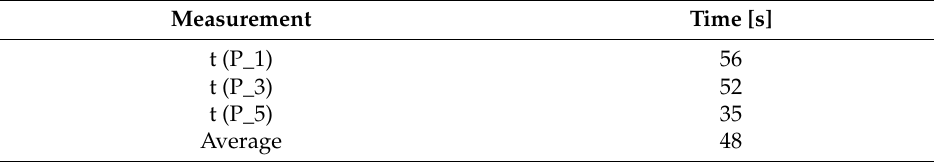
Table 1. Measurement results: startup for 3 phases (P = max, cos( φ ) = 1).